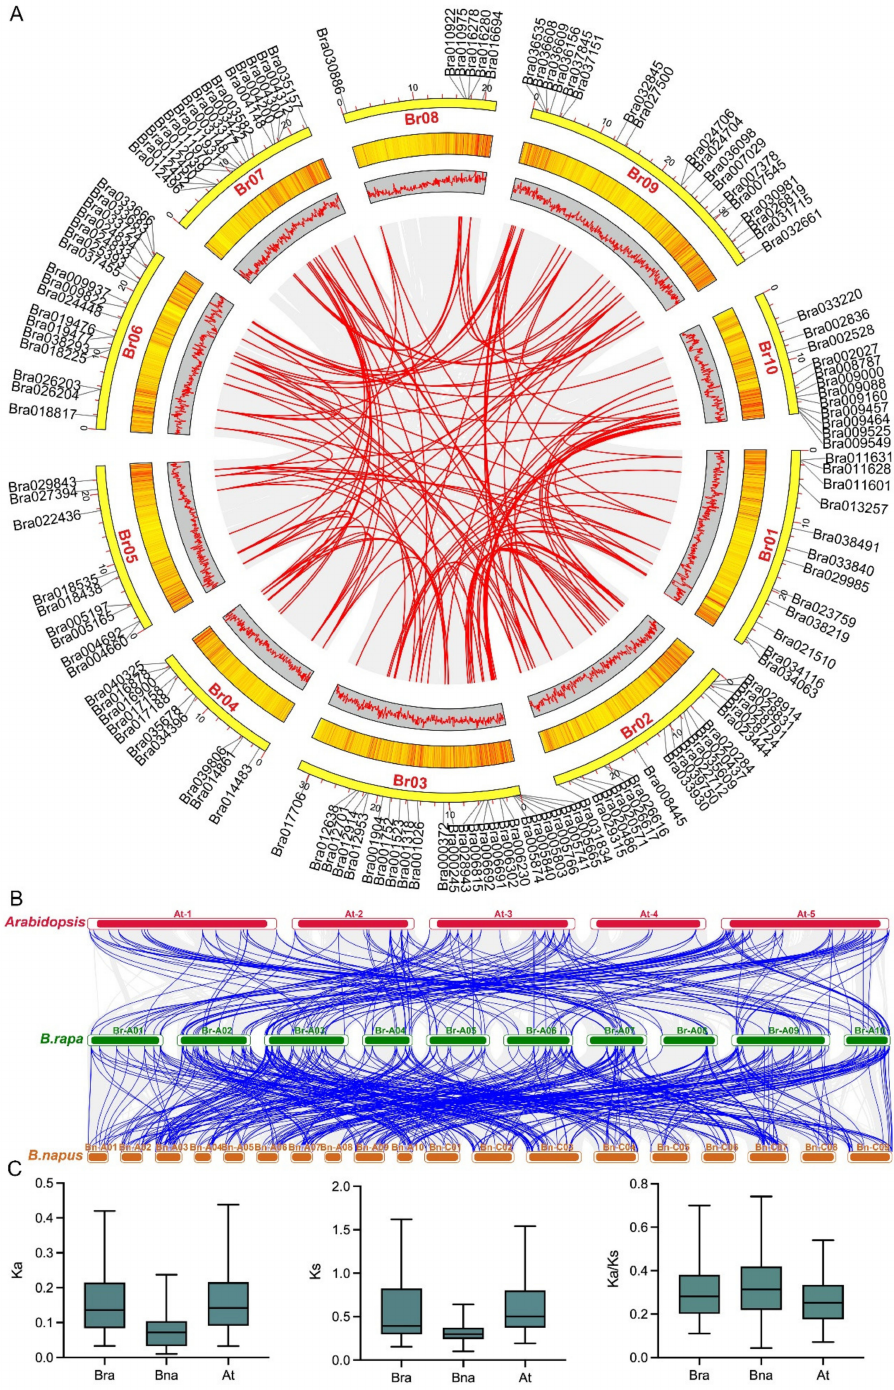
Figure 4. C2H2 ZFP gene family collinearity analysis. ( A ) The gene names are marked outwards on the corresponding chromosome. Duplicate gene pairs are highlighted with red lines. ( B ) The red, green, and orange indicate the chromosomes of Arabidopsis , B. rapa , and B. napus, respectively. Duplicate gene pairs are highlighted with blue connecting lines. ( C ) Ka, Ks, and Ka/Ks values of homologous gene pairs among